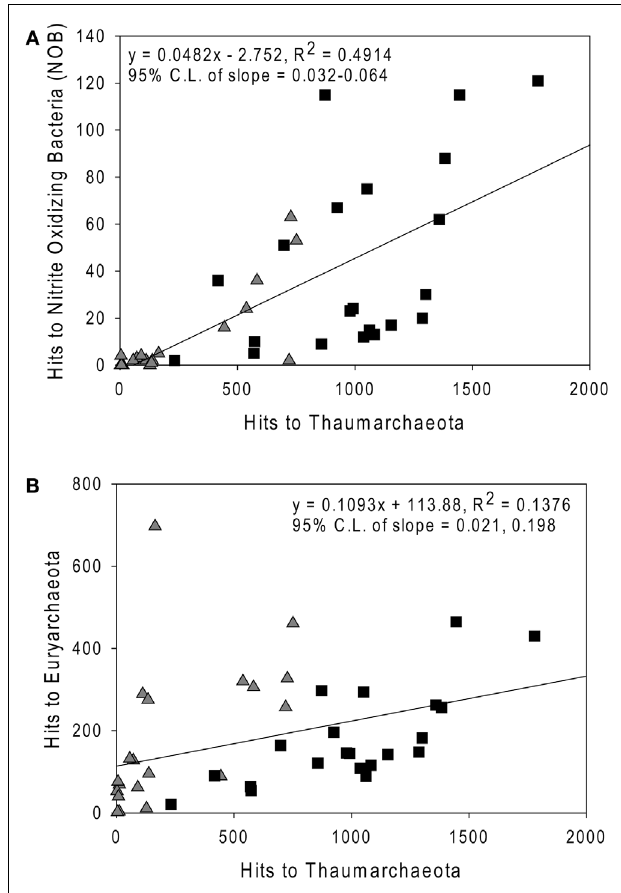
FIGURE 7 | Comparison of the abundance of rrs from (A) Nitrite-Oxidizing Bacteria; and (B) Euryarchaeota versus Thaumarchaeota rrs in samples from the northern Gulf of Mexico. Triangles, near-surface ( ≤ 100m) samples; squares, Deep ( > 100m) samples. Lines are model II regressions (Legendre and Legendre, 1998) of all